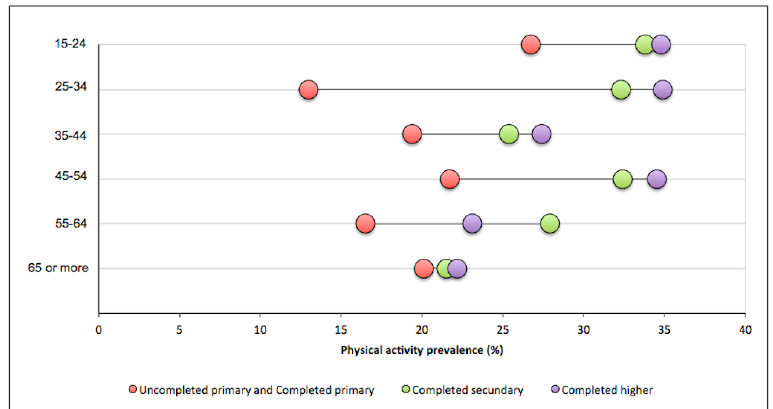
Figure 4. Differences in prevalence of adherence to the PA minimal weekly recommendation in Uruguay according to educational level and age group. Dots represent the different educational levels.